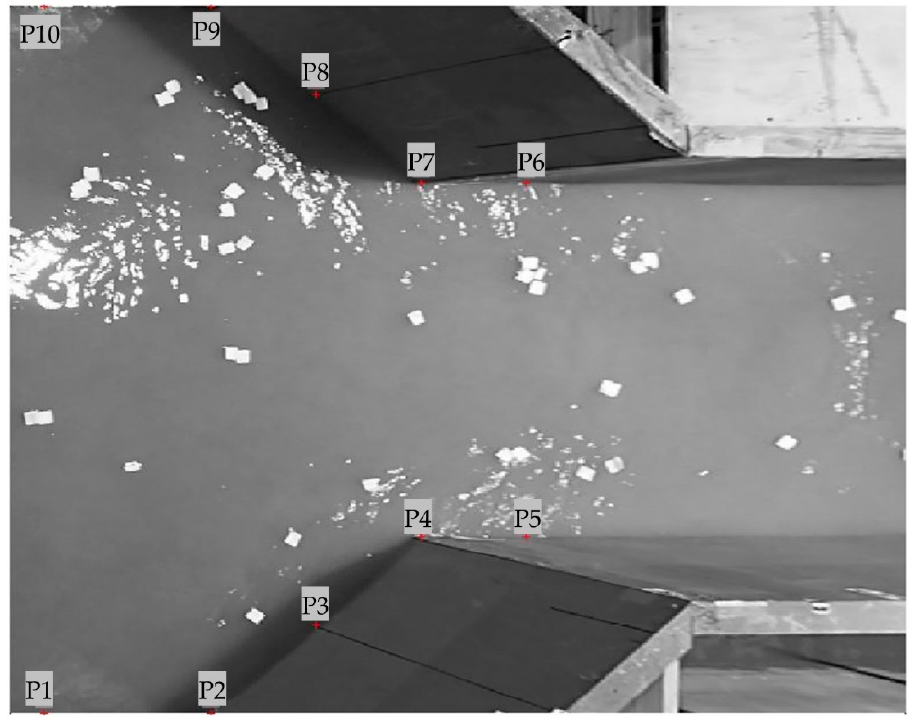
Figure 3. The orthorectified image for contraction ratios of B 2 /B 1 = 0.5.